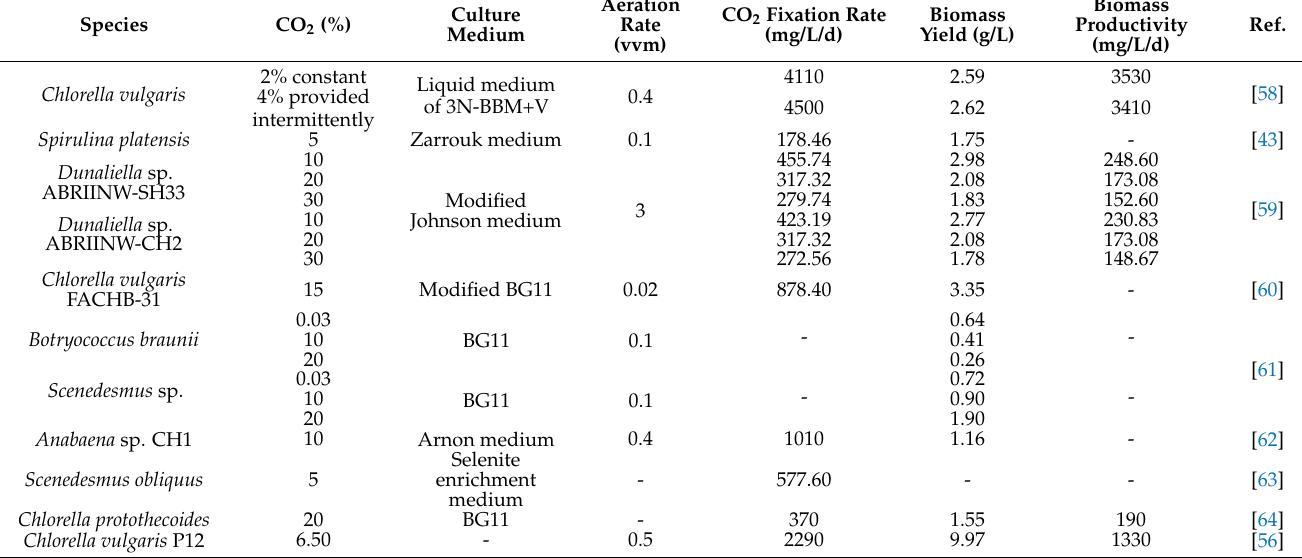
Table 2. Growth rates of different species of microalgae at different CO 2